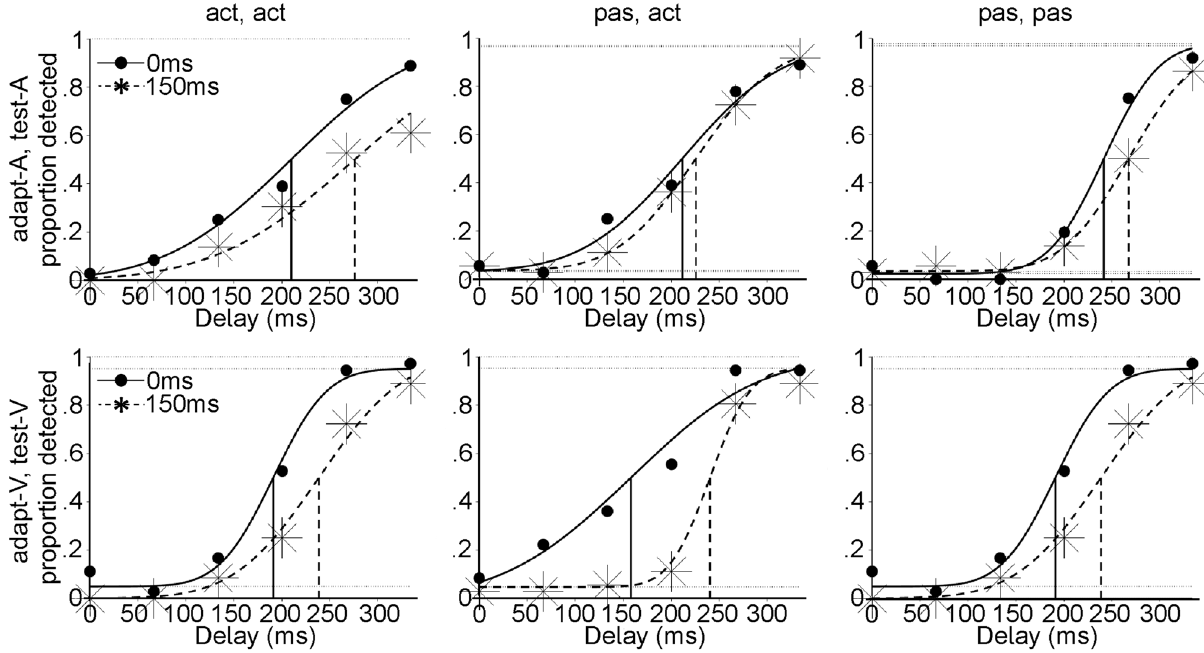
Figure 1. Plots showing detection responses and psychometric function fits for each condition from a representative participant. Filled circles and stars show proportion of detected responses as a function of test delay in the 0 ms and 150 ms adaptation delay conditions, respectively. A shift in detection thresholds from 0 to 150 ms delay indicates